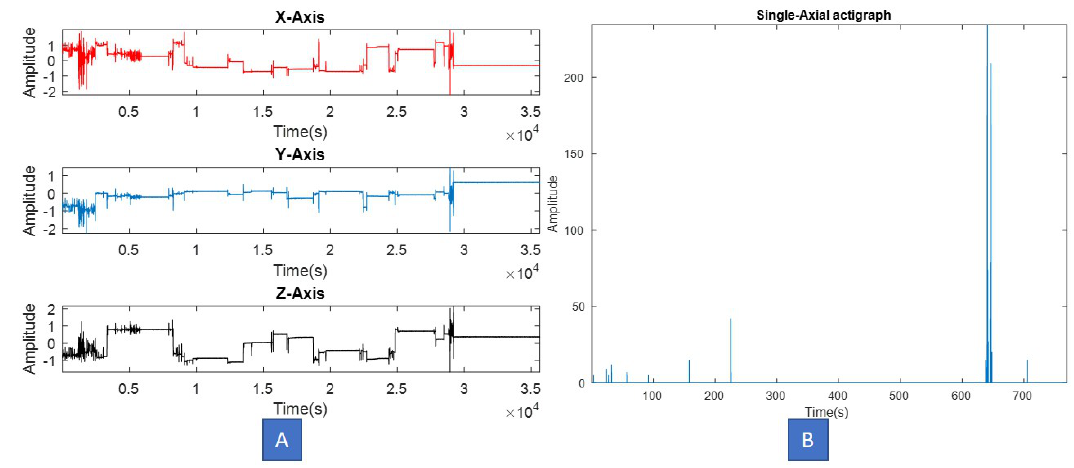
Figure 4. ( A ) Tri-axial, ( B ) Single axial actigraphy signal, captured from two different devices.